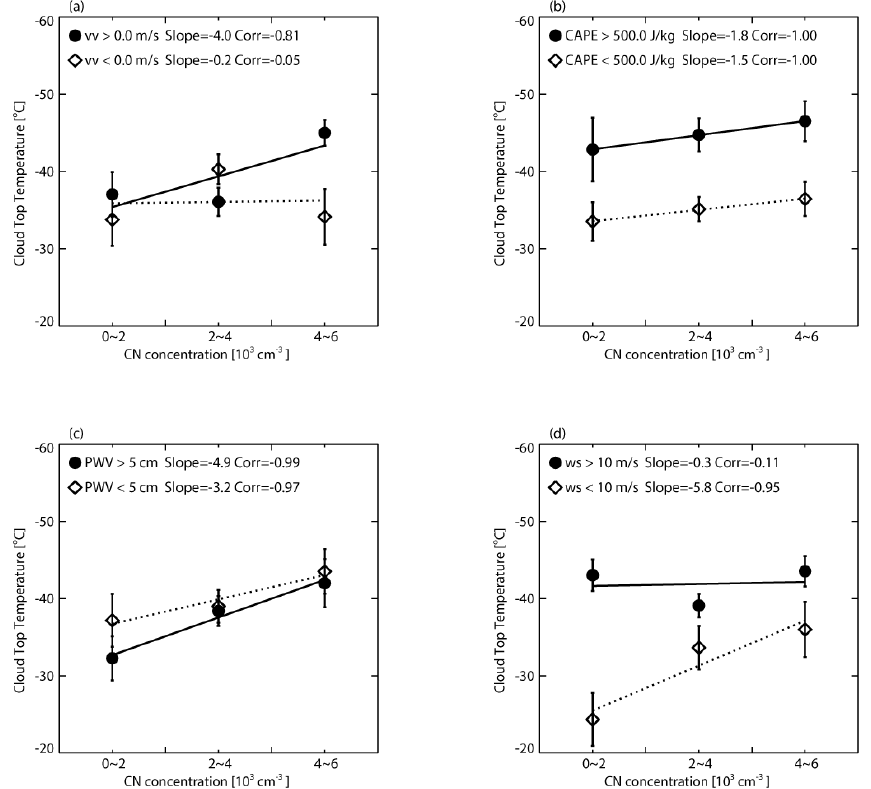
Figure 2. Cloud-top temperature as a function of aerosol CN concentration for deep convective clouds under different (a) vertical velocity (vv), (b) CAPE, (c) precipitable water vapor amount (PWV), and (d) wind shear (ws) conditions. Slopes and correlation coefficients of the different regressions are